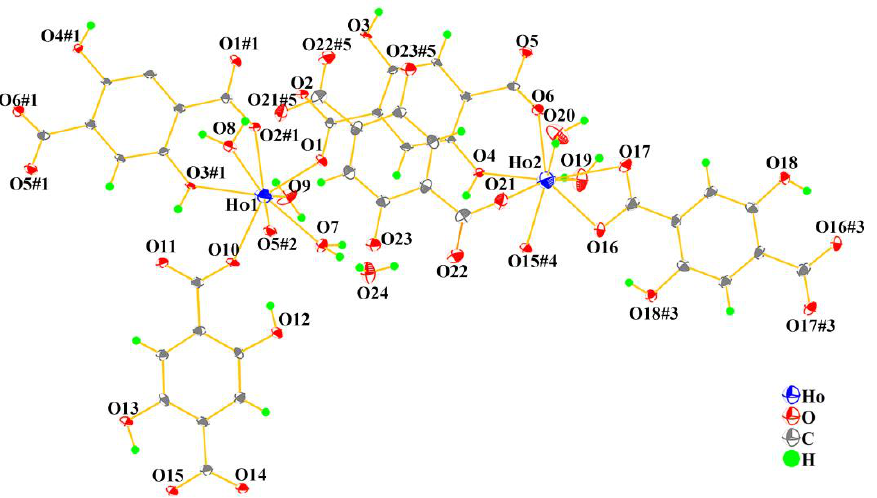
Figure 1. Coordination environment of the coordination complex 1 . (Symmetry codes for #1: 1-x, 2-y, 2-z; #2: x-1, y, z; #3: 2-x, -y, 1-z; #4: -x, 1-y, 1-z; and #5: 1-x, 1-y, 2-z.).